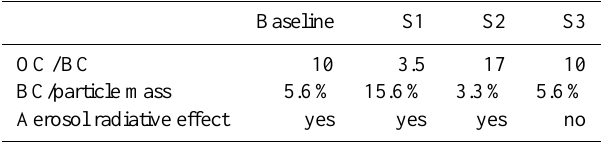
Table 2. Experiments